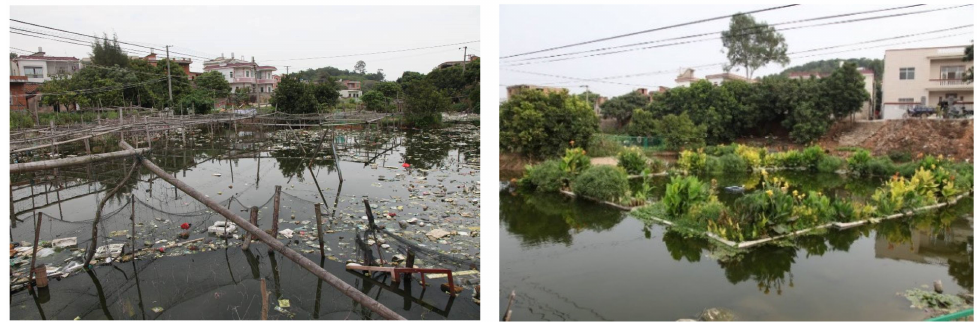
Figure 9. Sewage pond before construction ( left ) and ecological pond after construction ( right